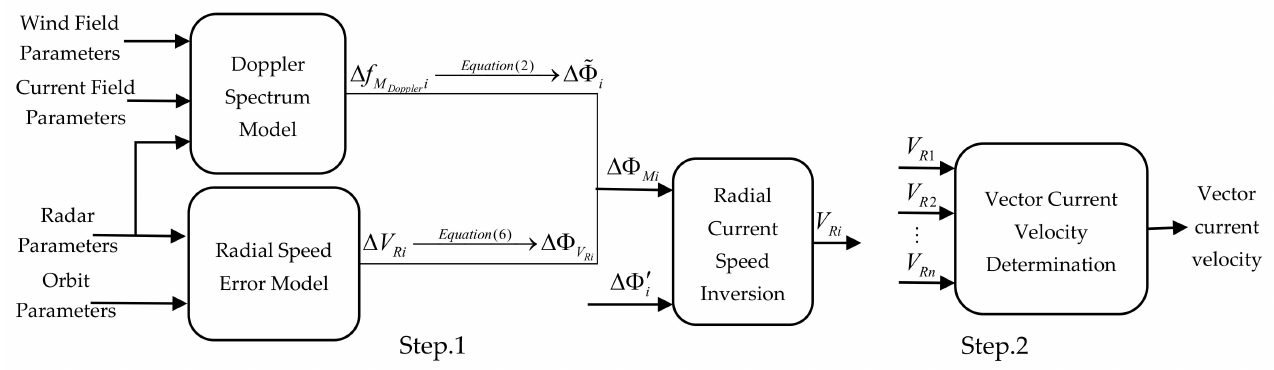
Figure 2. Flowchart of Doppler scatterometry current velocity